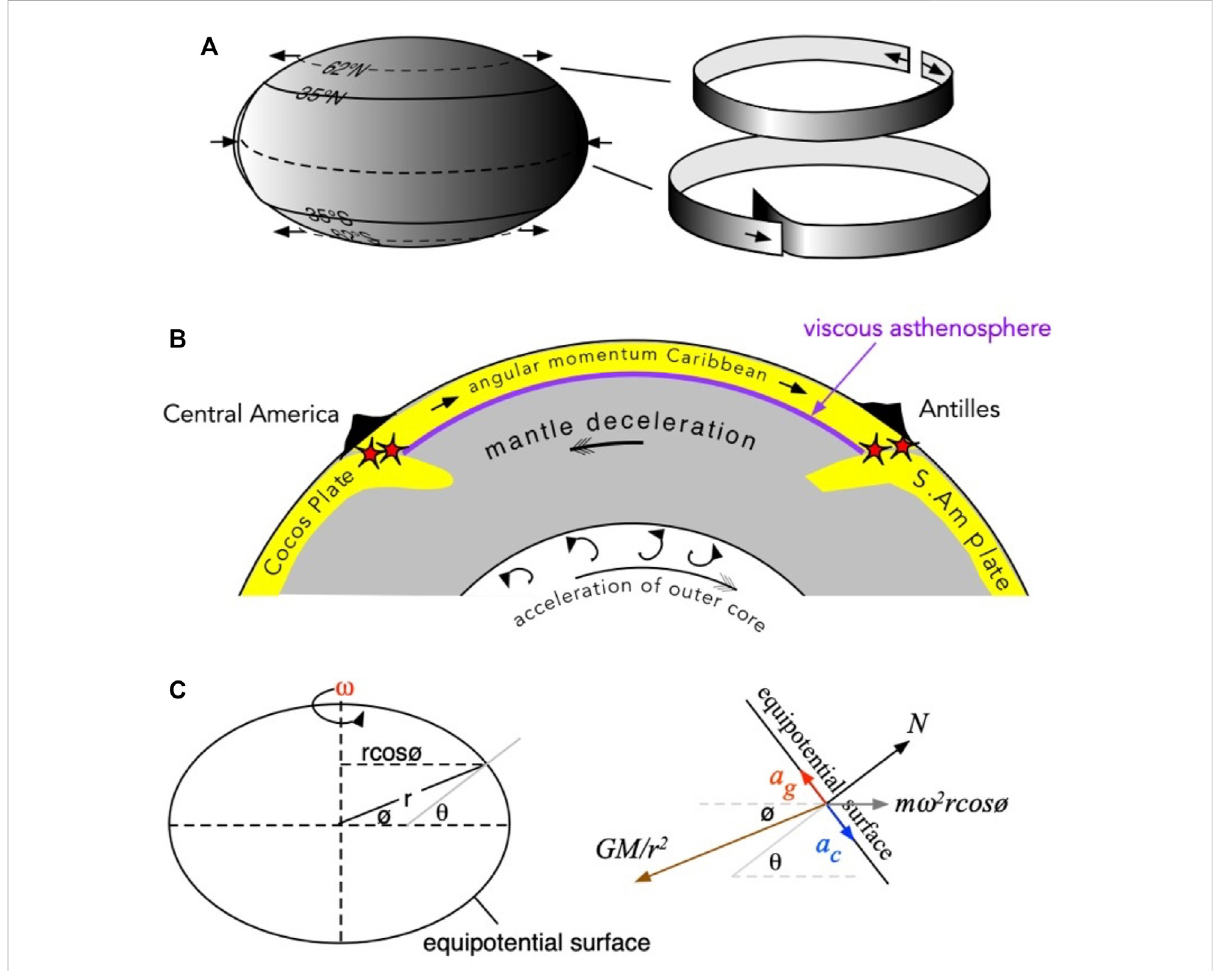
FIGURE 7 Schematic views of coupling between an incremental slowing in Earth ’ s spin velocity and lithospheric stresses. (A) A slowing in rotational velocitydecreasesEarth ’ soblateness,extendingsmallcirclesinpolarregionsanddecreasingthemintropicalregions. (B) Schematicsectionthrough equator viewed from south pole showing sense of Euler forces attending deceleration. (C) Resolved horizontal accelerations acting on a point mass on the equatorial bulge (a g = a c ) exactly cancel, but surface-normal gravity increases with decreasing angular